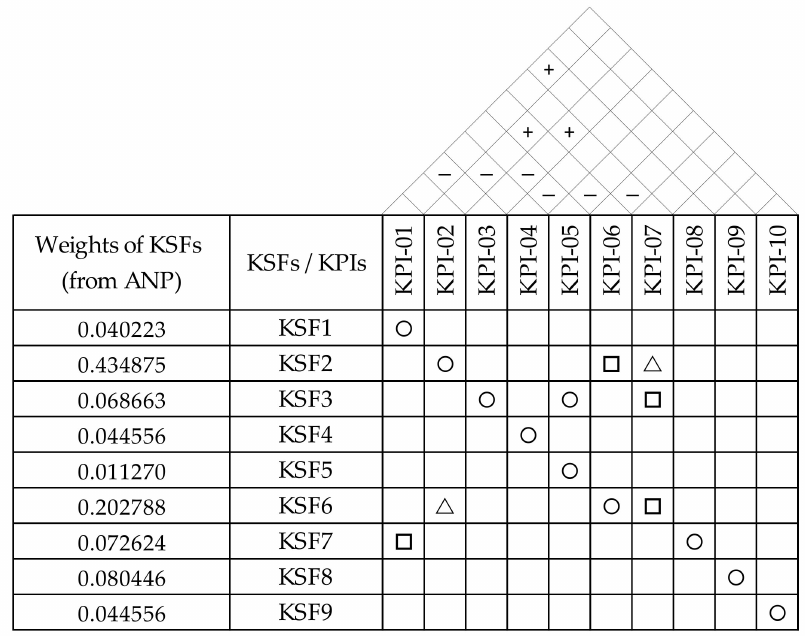
Figure 5. Relationships and impacts between KSFs and